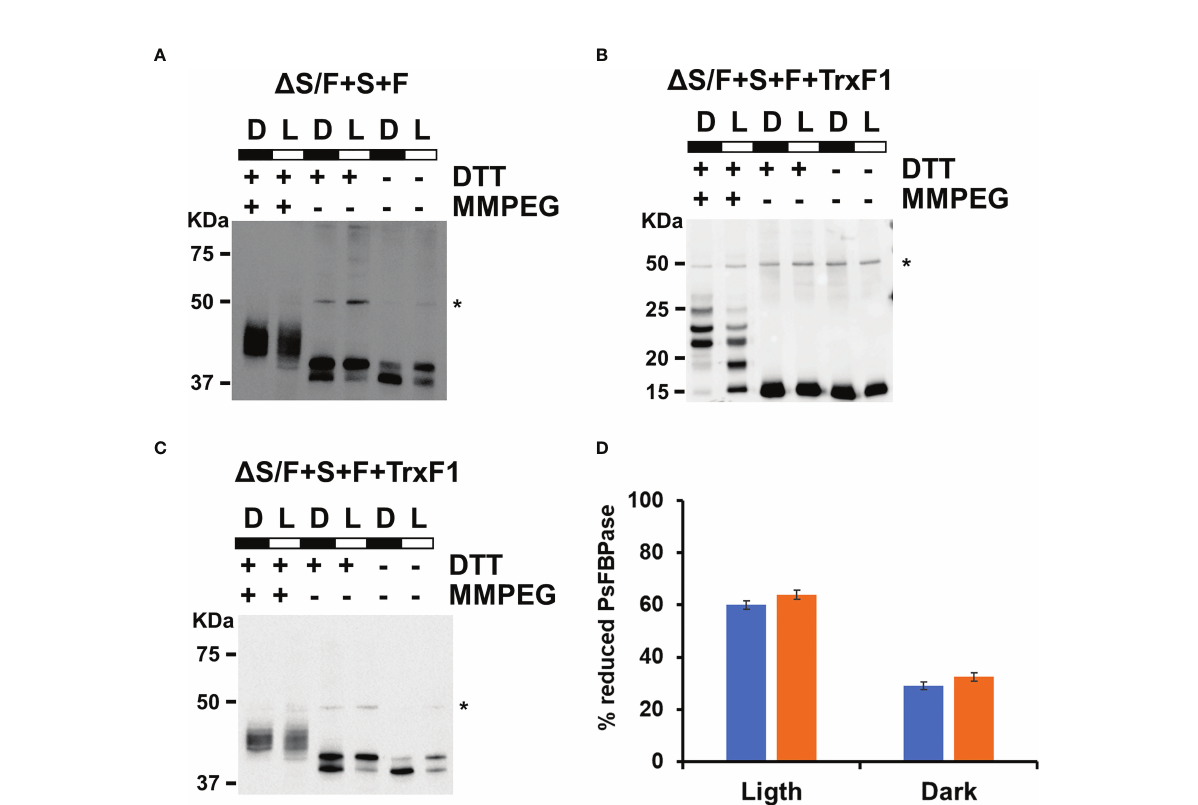
FIGURE 4 Both PsFBPase and TrxF1 are light regulated in Synechocystis . (A) In vivo PsFBPase L/D regulation analyzed by Western blot in the D S/F+S+F strain. Proteins were extracted from labeling of D S/F+S+F cells in the light (L) and after 24 h in the dark (D) and labeled with the alkylating agent MM(PEG24) and analyzed using anti-PsFBPase as described in the “ Materials and methods ” . * Denotes a cross reacting band. (B) In vivo TrxF1 L/ D regulation analyzed by Western blot in the D S/F+S+F+TrxF strain. Proteins were extracted from labeling of D S/F+S+F+TrxF cells in the light (L) and after 24 h in the dark (D) and labeled with the alkylating agent MM(PEG24) and analyzed using anti-TrxF1 antibodies as described in the “ Materials and methods ” . * Denotes a cross reacting band. (C) Western blot L/D regulation in vivo of PsFBPase in the D S/F+S+F+TrxF strain. Proteins were extracted from labeling D S/F+S+F+TrxF cells in the light (L) and after 24 h in the dark (D) and labeled with the alkylating agent MM (PEG24) and analyzed using anti-PsFBPase as described in the “ Materials and methods ” . * Denotes a cross reacting band. (D) Quanti fi cation of the reduced and oxidized forms of PsFBPase in D S/F+S+F (blue bars) and D S/F+S+F+TrxF strains (orange bars) in the light and in the